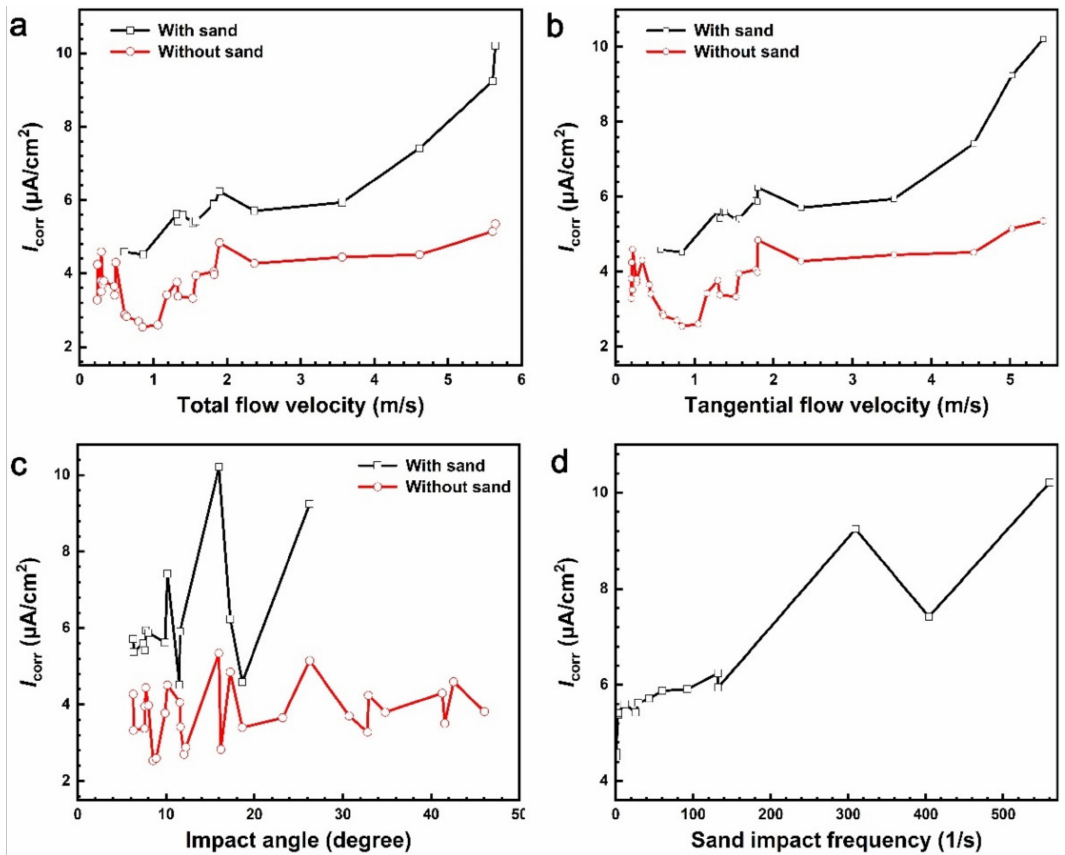
Figure 11. Variation of corrosion current density ( I corr ) of 90/10 copper–nickel alloy with the fluid parameters of ( a ) total flow velocity, ( b ) tangential flow velocity, ( c ) impact angle and ( d ) sand impact